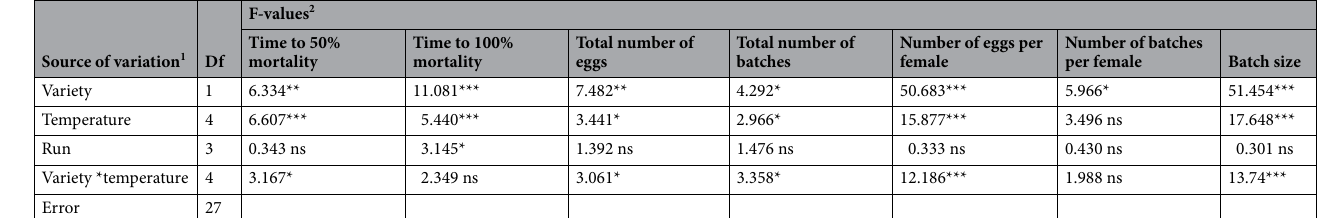
Table 2. F-values from univariate GLMs for adult female longevity and oviposition at the end of 20 days (see Fig. 2). 1 Run = temporal replicate that includes observations for all temperatures conducted across